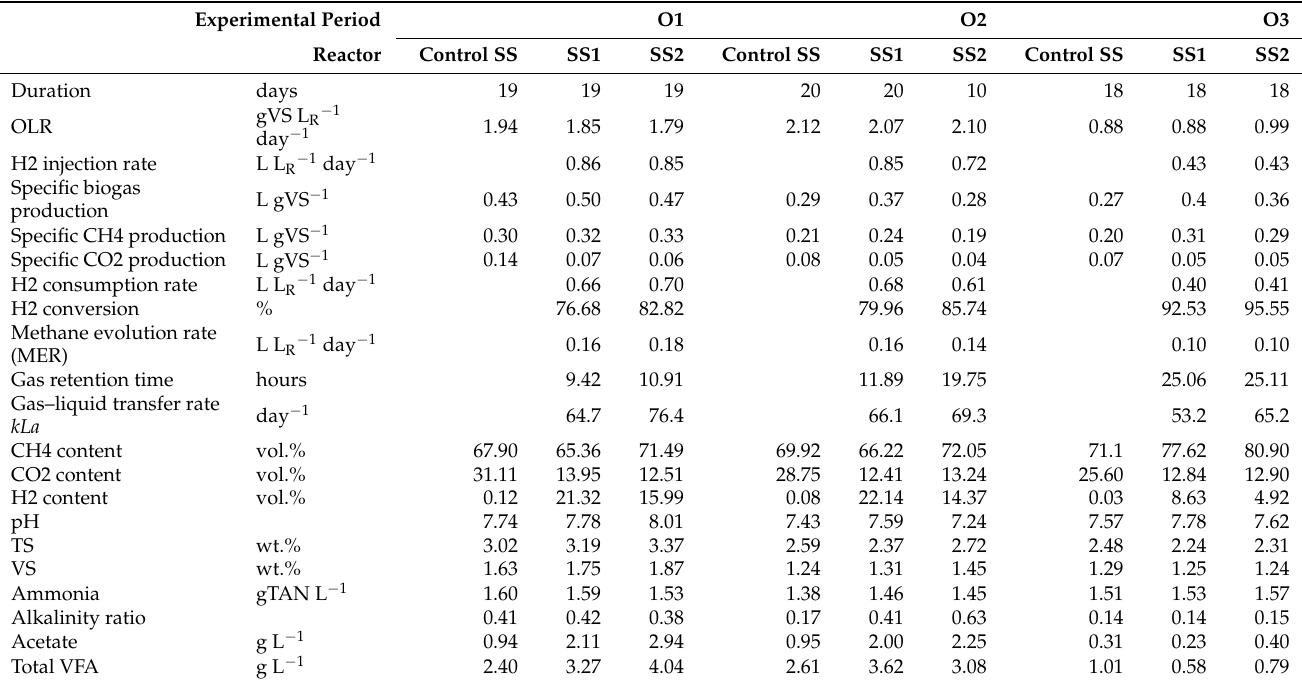
Table A5. Average in-situ biomethanation results for sewage sludge (SS)-fed reactors across opera- tional periods O1–O3.